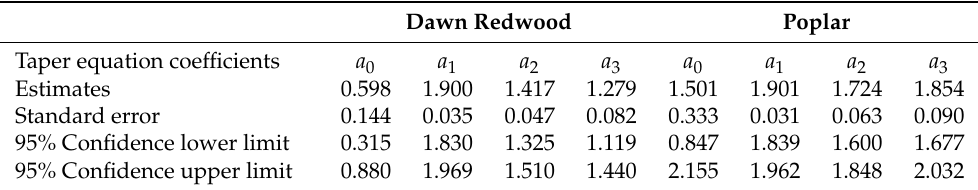
Table 7. Parameters and analysis of the optimal taper function models of dawn redwood and